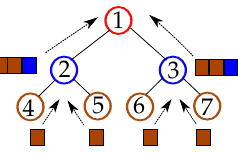
Figure 1. Data collection along a convergecast tree Our sensor network is not a dense deployment of nodes since it focuses on covering a large area with a small number of nodes so that the network will be a cost-e ff ective solution to monitor the soil moisture and other parameters. Hence, we are assuming that all the sensor readings are equally important and are required to be transmitted to the sink node. So the data collection in our network is of the type shown in Fig.